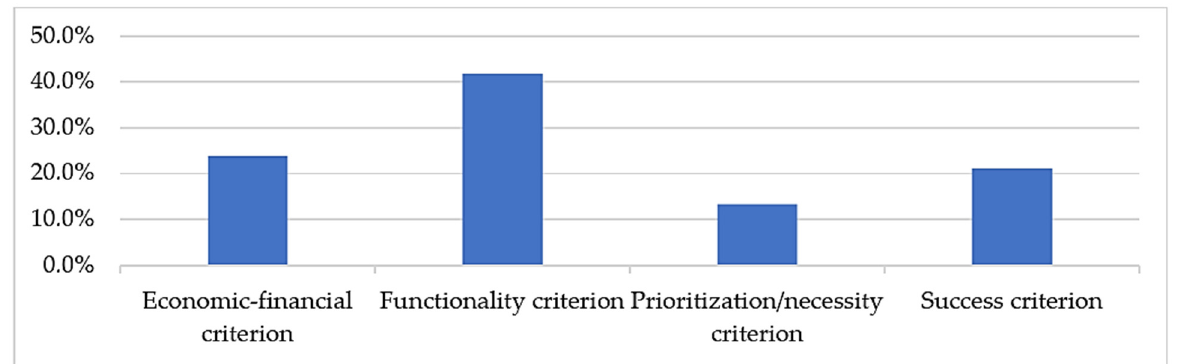
Figure 6. Graphic representation of results for the evaluated criteria—fuzzy AHP method.